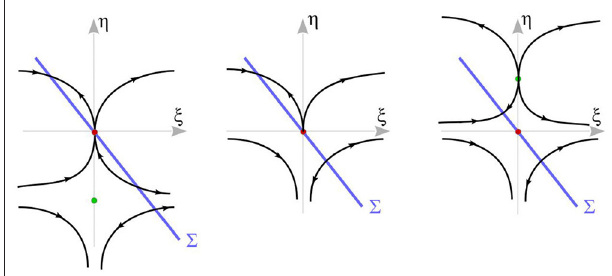
FIGURE 13 | The singular saddle-node bifurcation of type II at ( ξ ∗ , η ∗ , α ∗ ) = (0,0,0) for 1 4 > 0 and f 1 x > 0. As α changes from negative to positive, the local flow changes from the left figure to right figure.